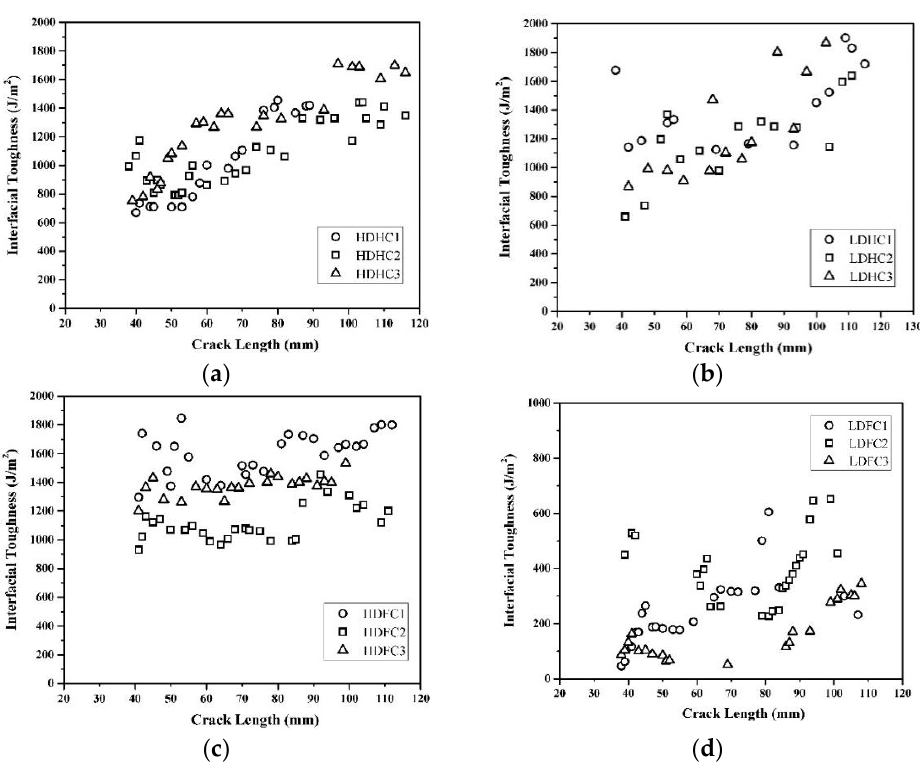
Figure 13. Debond resistance curve (G Ic vs. a) for SCB sandwich structures: ( a ) HDHC; ( b ) LDHC; ( c ) HDFC; ( d ) LDFC.